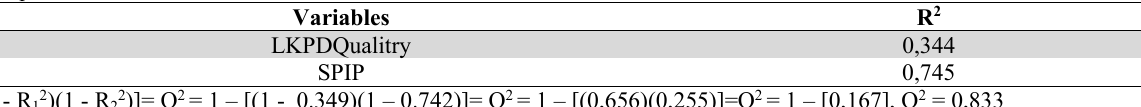
Q-Squared Predictive Relevance